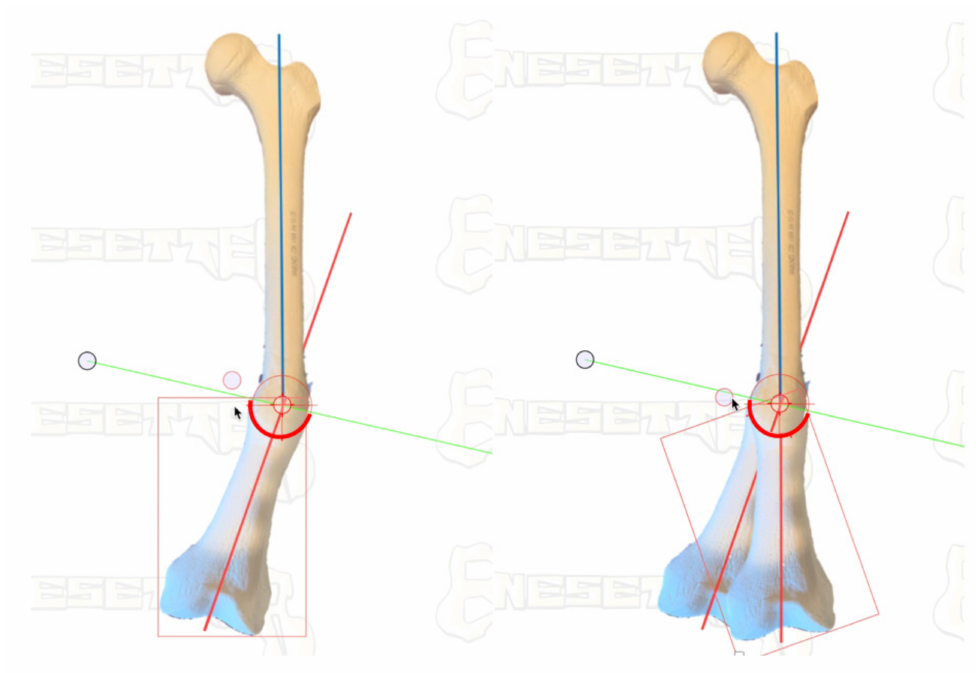
Figure 1. Focal Dome Osteotomy Concept. The Center of Rotation of Angulation (CORA) is the intersection of proximal and distal anatomical axes through a deformity. Focal Dome Osteotomy is an arcuate osteotomy based on a semicircular cut centered at and rotated about the CORA. The distal femur in this example rotates around CORA, fully correcting the deformity (blue and red axis lines become